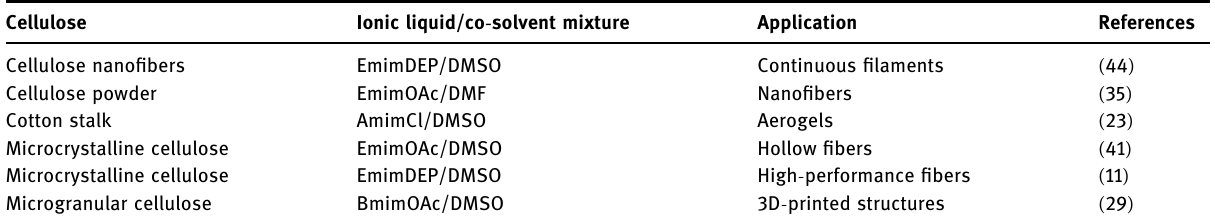
Table 9: Examples of applications of cellulose regenerated from cellulose/imidazolium - based ionic liquid/co - solvent solutions Cellulose Ionic liquid/co - solvent